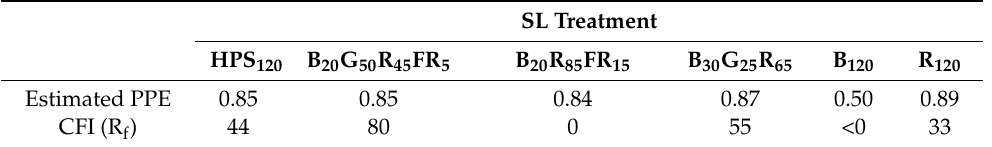
Table 3. Estimated phytochrome photoequilibria (PPE; P FR /P R+FR ) and color fidelity index (CFI; R f ) of each supplemental lighting (SL) treatment. PPEs were calculated according to Sager et al. (1988), and CFI values were calculated according to supplemental materials provided by IES (2018). SL treatments consisted of either 460 W high-pressure sodium fixtures (HPS 120 ; LR48877; P.L. Light Systems, Beamsville, ON, Canada), 631 W light-emitting diode (LED) fixtures (B 20 G 50 R 45 FR 5 ; VYPR 2p; Fluence, Austin, TX, USA), 325 W LED fixtures (B 20 R 85 FR 15 ; LumiGrow Pro 325; LumiGrow, Emeryville, CA, USA), 600 W LED fixtures (B 30 G 25 R 65 ; LX601G, Heliospectra, Göteborg, Sweden), a combination of 72 W LED fixtures (B 120 ; HortiLED MULTI, P.L. Light Systems) and 625 W LED fixtures (R 120 ; LumiGrow Pro 650E, LumiGrow), or 625 W LED fixtures (LumiGrow Pro 650E; LumiGrow).